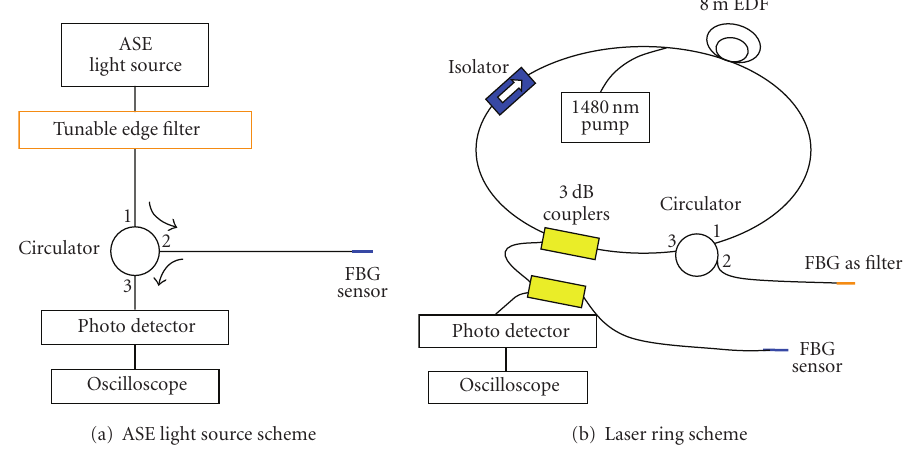
Figure 2: Two interrogation schemes used to demodulate the wavelength variations in the sensing FBG.